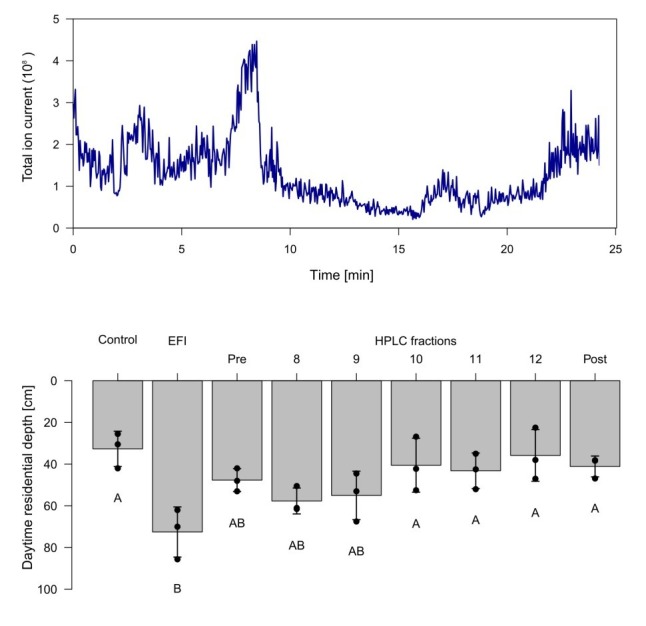
Chromatogram and biological activity of extracted fish incubation water (EFI).(a) Chromatogram of EFI after separation on a 250 mm x 4 mm reversed phase column (Nucleosil 100-5-C18, Macherey-Nagel, Düren, Germany) using the mobile phases A H2O and B MeOH with the portion of B increasing over time. The total ion current of ESI-MS measurements in the negative ionization mode are depicted. (b) Behavioral response of Daphnia magna to extract of fish incubation water (EFI) and fractions thereof. Fraction numbering corresponds to the time of the chromatogram [min], while fraction “Pre” contains the collected eluate from 0-8 min and fraction “Post” that from 13-25 min. The control contains the same volume of pure organic solvent as tested from EFI and its fractions. Mean Daphnia daytime residence depth (+/- SD, n=4). Different capital letters indicate significant differences among treatments one-way ANOVA followed by Tukey post-hoc). Statistical results are summarized in Supplementary file 1.